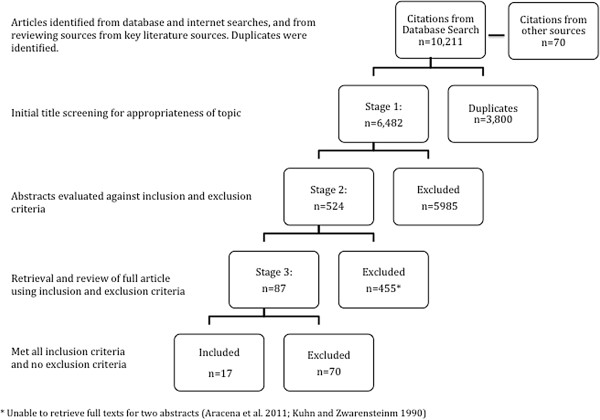
Article screening.